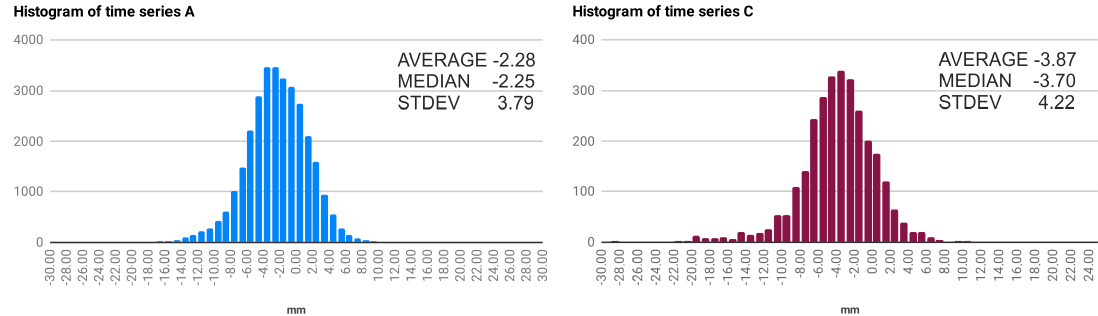
Figure 13: Figure 11. Histograms and basic statistics for time series ( A ) and ( C ).